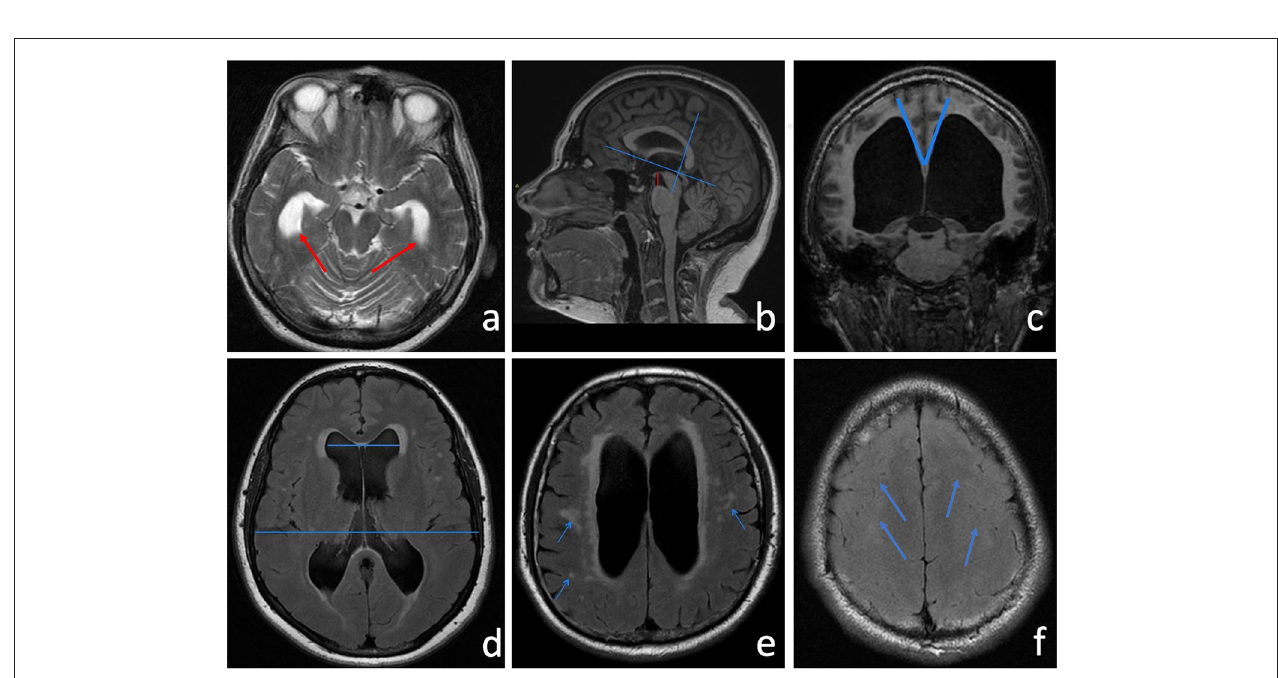
Frontiers in Neurology |